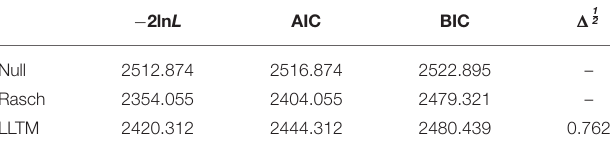
TABLE 4 | The goodness of fit in the null model, Rasch model, and LLTM. TABLE 5 | Item difficulty parameters in the Rasch model and LLTM.